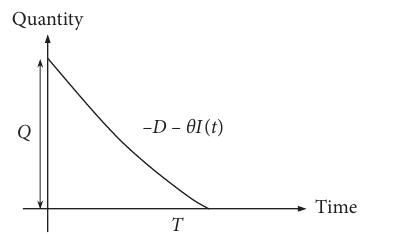
Figure 1: Inventory level of the retailer at time 0 ≤ t ≤ T .